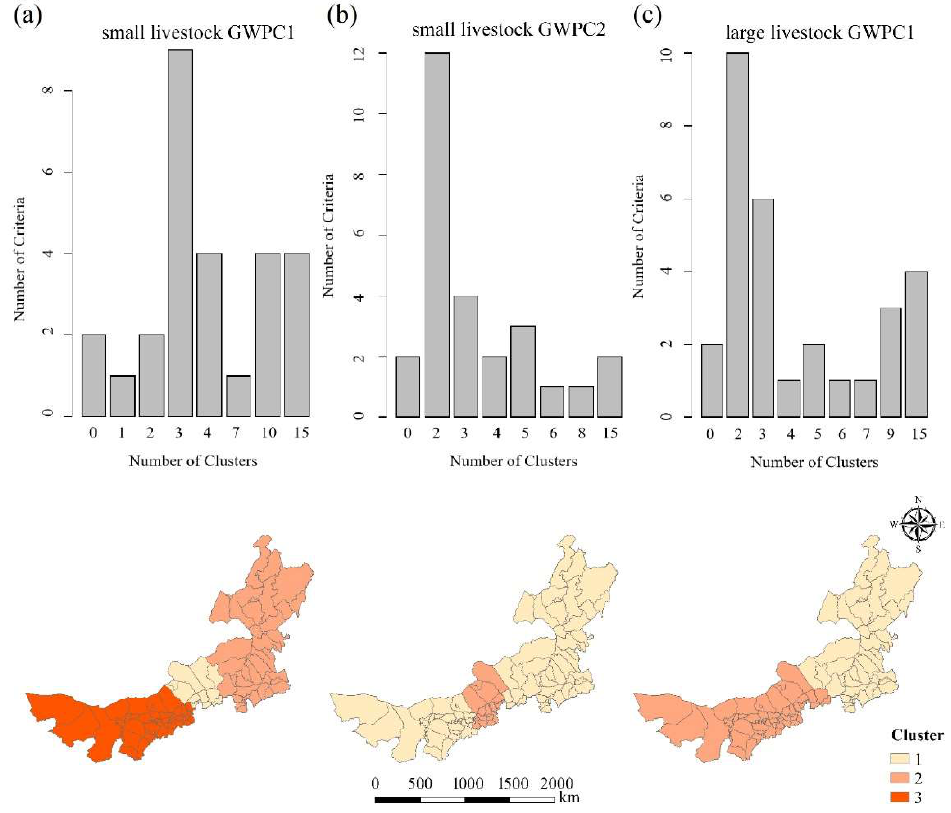
Figure 7. Optimal number of clusters and the distribution of clusters based on GWPCA loading. ( a ) small livestock GWPC1; ( b ) small livestock GWPC2 and ( c ) large livestock GWPC1.